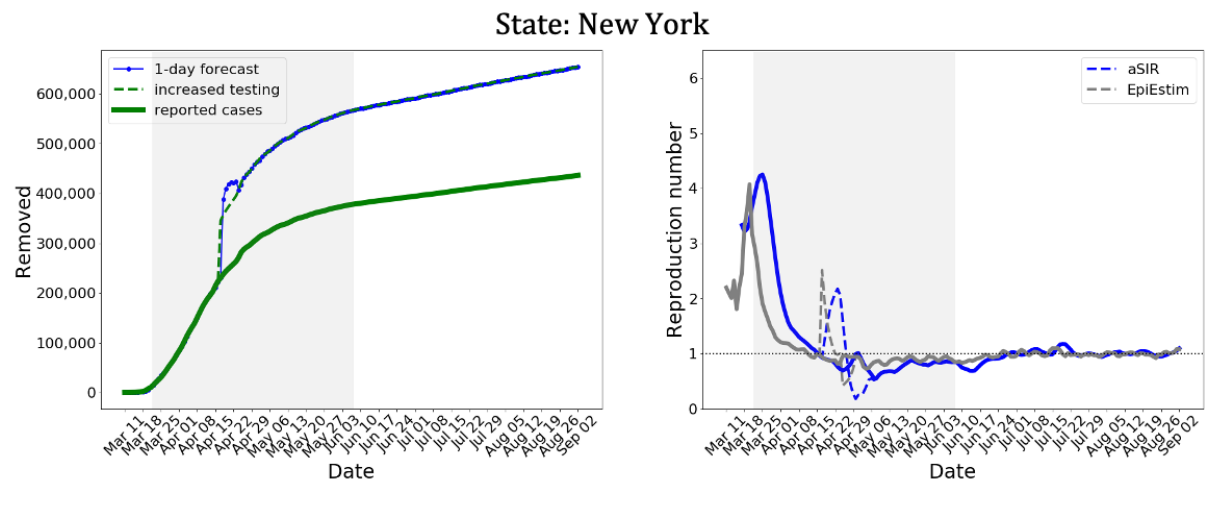
Figure 3. Effect of a step-wise 50% increase in testing (left panel, dashed line). The 1-day forecast by the aSIR model adapts within a week. For the Rt estimate, both EpiEstim and our aSIR models produced a spike, followed by a reduction (right panel, dashed lines) before returning to the unperturbed Rt time course (solid lines). aSIR: adaptive